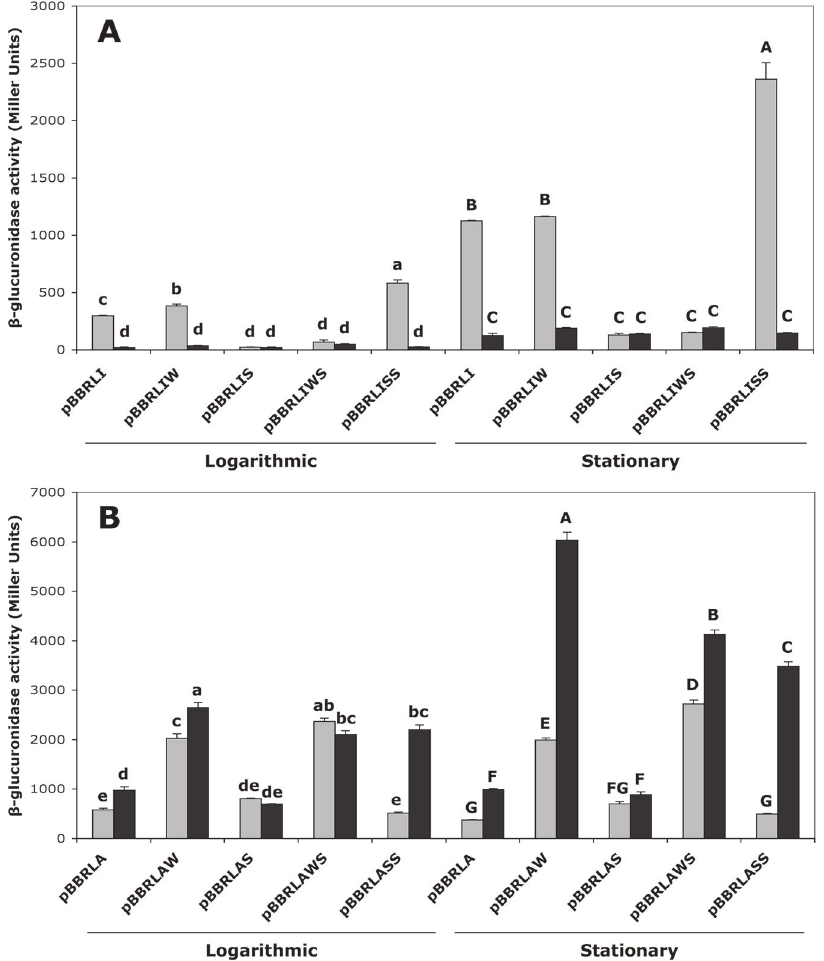
Fig 3. Role of the TyrR boxes in akr-ipdC gene regulation. Expression from (A) ipdC and (B) akr promoter mutants in wild-type E . cloacae UW5 (grey) and tyrR null mutant E . cloacae J35 (black) in tryptophan- supplemented M9 minimal media. Cells were assayed for β -glucuronidase activity in both logarithmic and stationary phases of growth. Error bars represent the standard error of means of three independent replicates. Statistically significant differences of p < 0.05 are indicated by lowercase letters in logarithmic phase, and uppercase letters in stationary